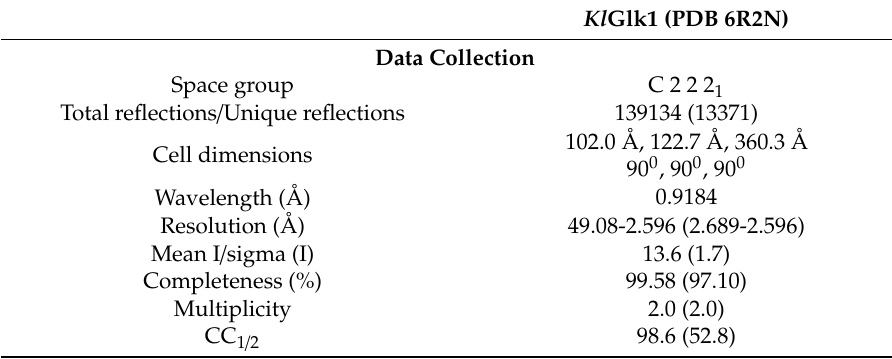
Table 1. Data collection and refinement